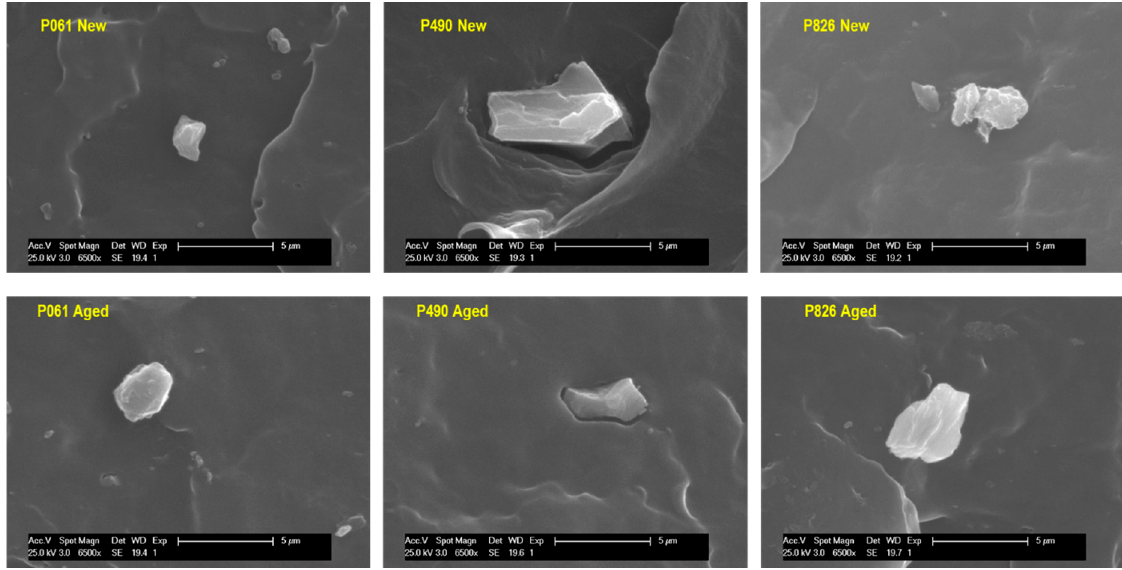
Figure 6. SEM micrographs obtained from cryofractured surfaces for the indicated pipes.